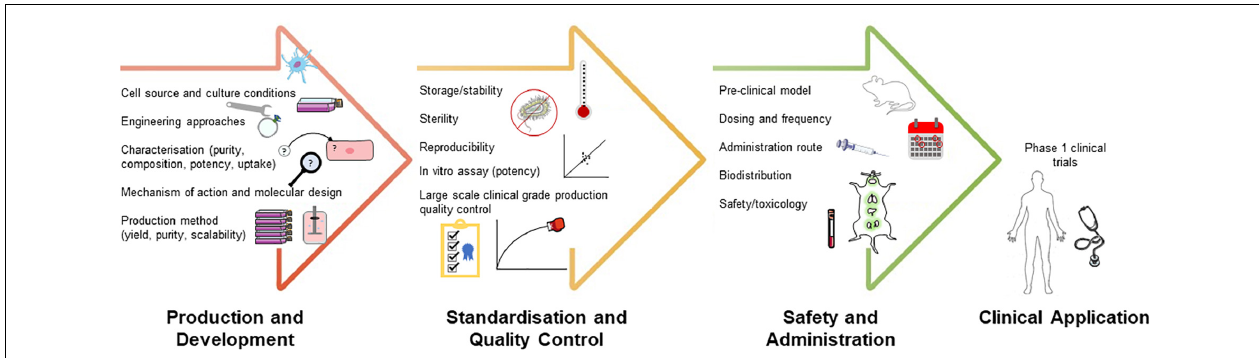
FIGURE 1 | Challenges and translational considerations of development of EV-based therapeutics. Developing rational targeting or therapeutic strategies for these different stages will advance the application of EV-based therapeutics.